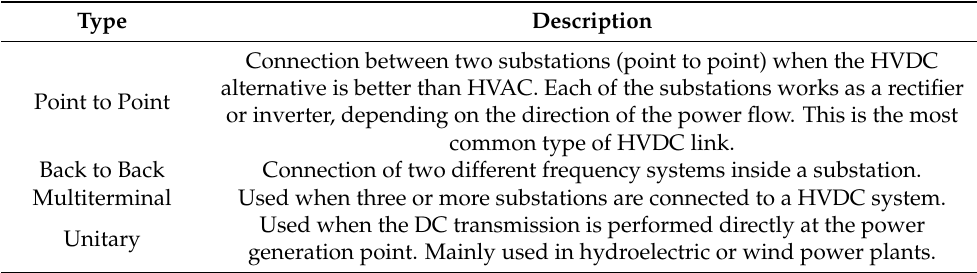
Table 1. Different configurations for HVDC systems.